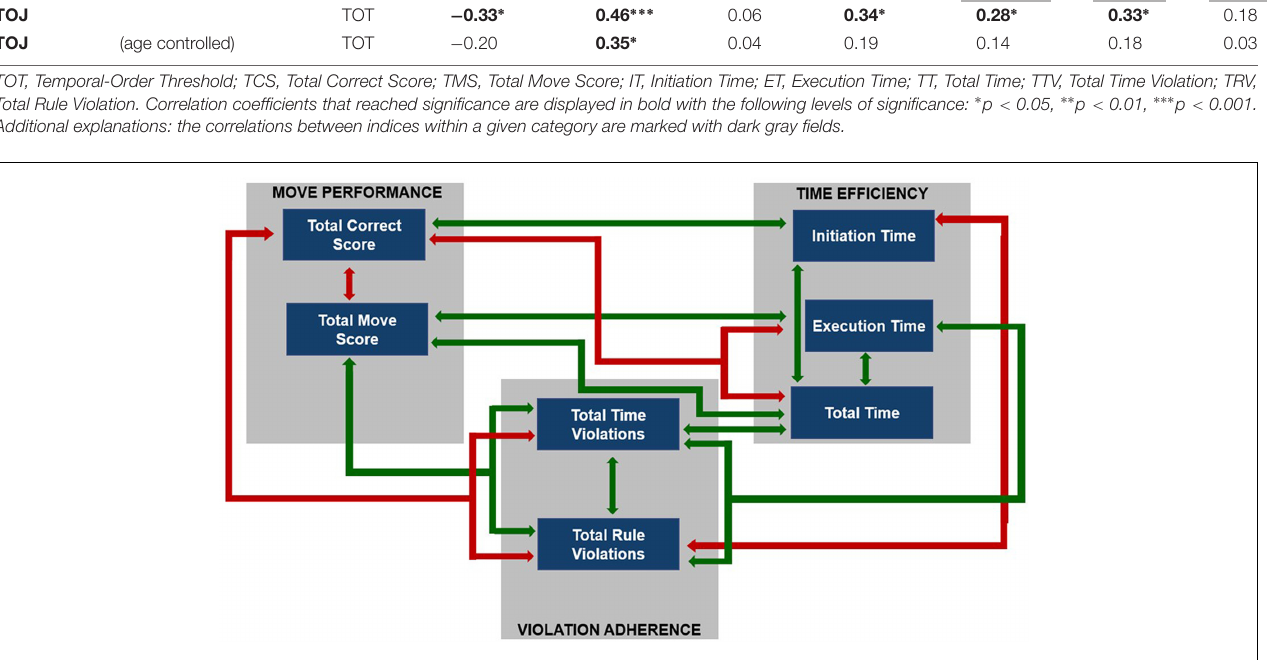
FIGURE 4 | The summary of intercorrelations between TOL DX outcome measures. Arrows indicate significant correlations: green arrows reflect positive correlations and red arrows -negative